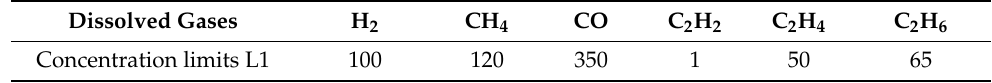
Table 1. Concentration limits L1 of dissolved gases.